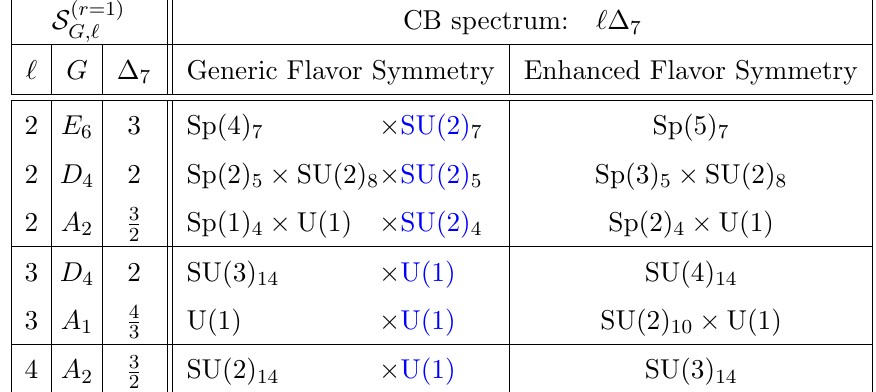
Table 4. The pattern of symmetry enhancement of S ( r =1) . Note that often a subgroup of G G;‘ and the isometry of C 2 = Z ‘ combine to form a larger simple component of the enhanced (cid:13)avor symmetry. We also note that the symmetry of low-rank T theories enhance: the T ( r =1) theories G;‘ have the full symmetry G , since they are equal to the old rank-1 theory with G symmetry plus a free hypermultiplet, whereas for the T ( r =2) theories the isometry SU(2) symmetry for ‘ = 2 enhances G;‘ to SU(2) 2 while the isometry U(1) symmetry for ‘ 6 = 2 enhances to SU(2). The subscripts are